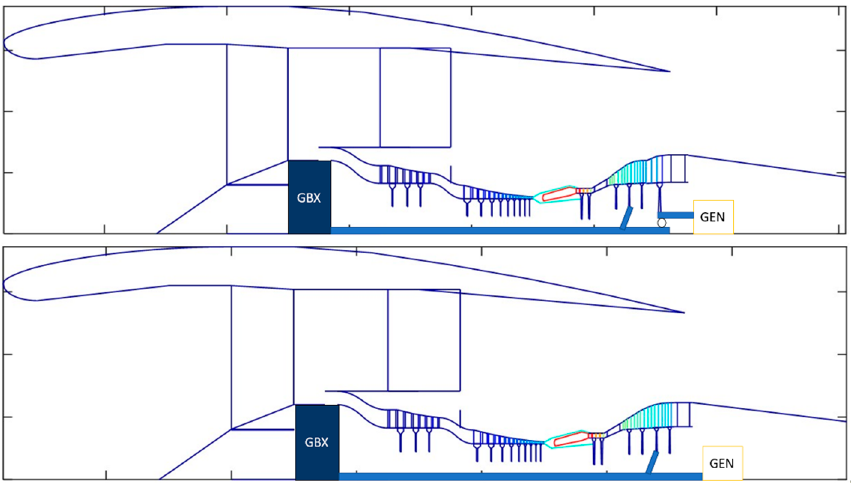
Figure 28. Flow path layout of the main power plant design options, free power turbine power offtake ( top ) and low-pressure turbine power offtake ( bottom ).